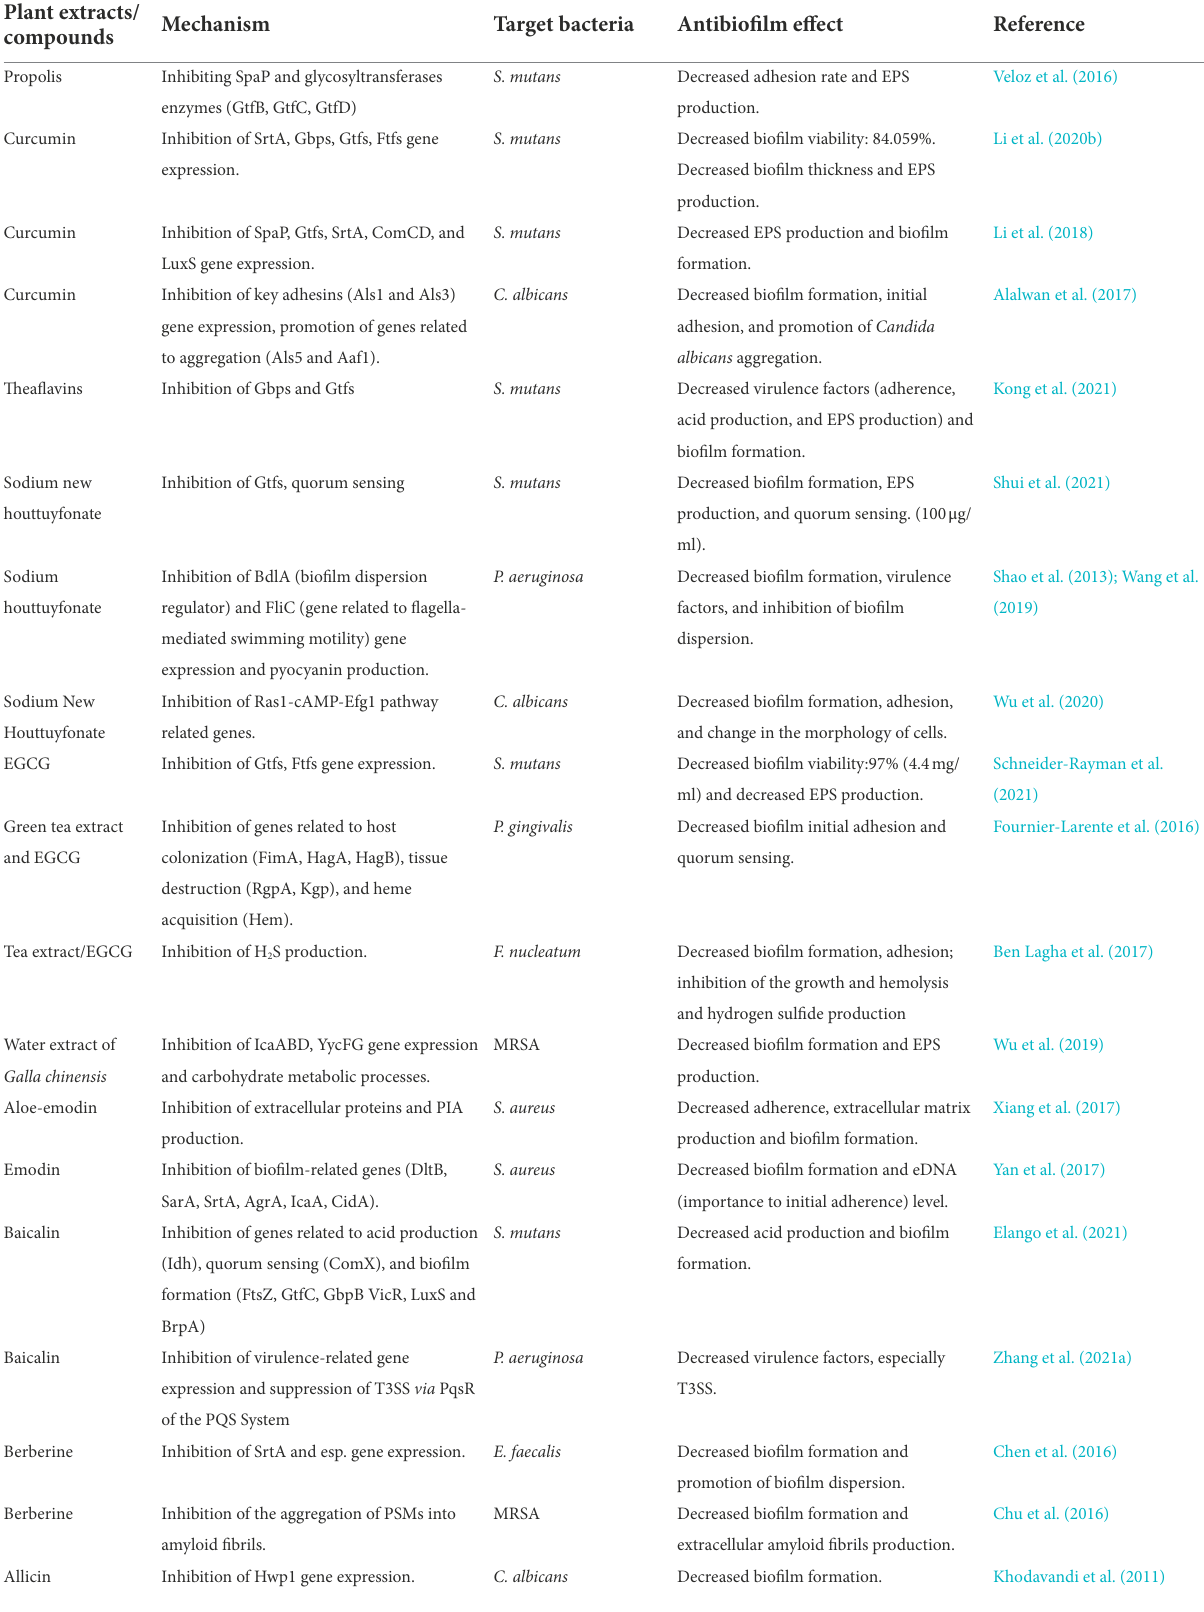
TABLE 1 Anti-oral biofilm natural products and their molecular